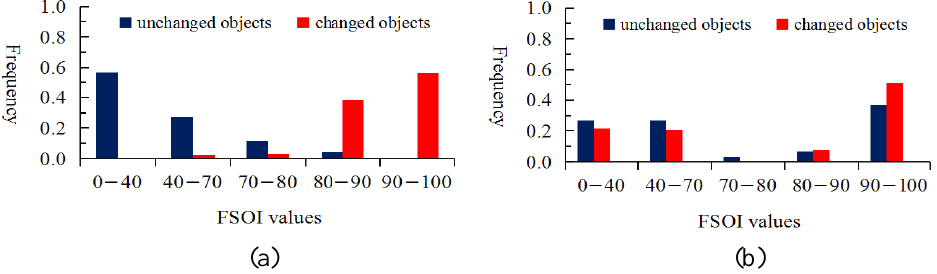
Figure 15. Frequency distribution of outlier detection. ( a ) The results of outlier detection with the op- timal texture feature selection, and ( b ) the results of outlier detection without texture feature selection.